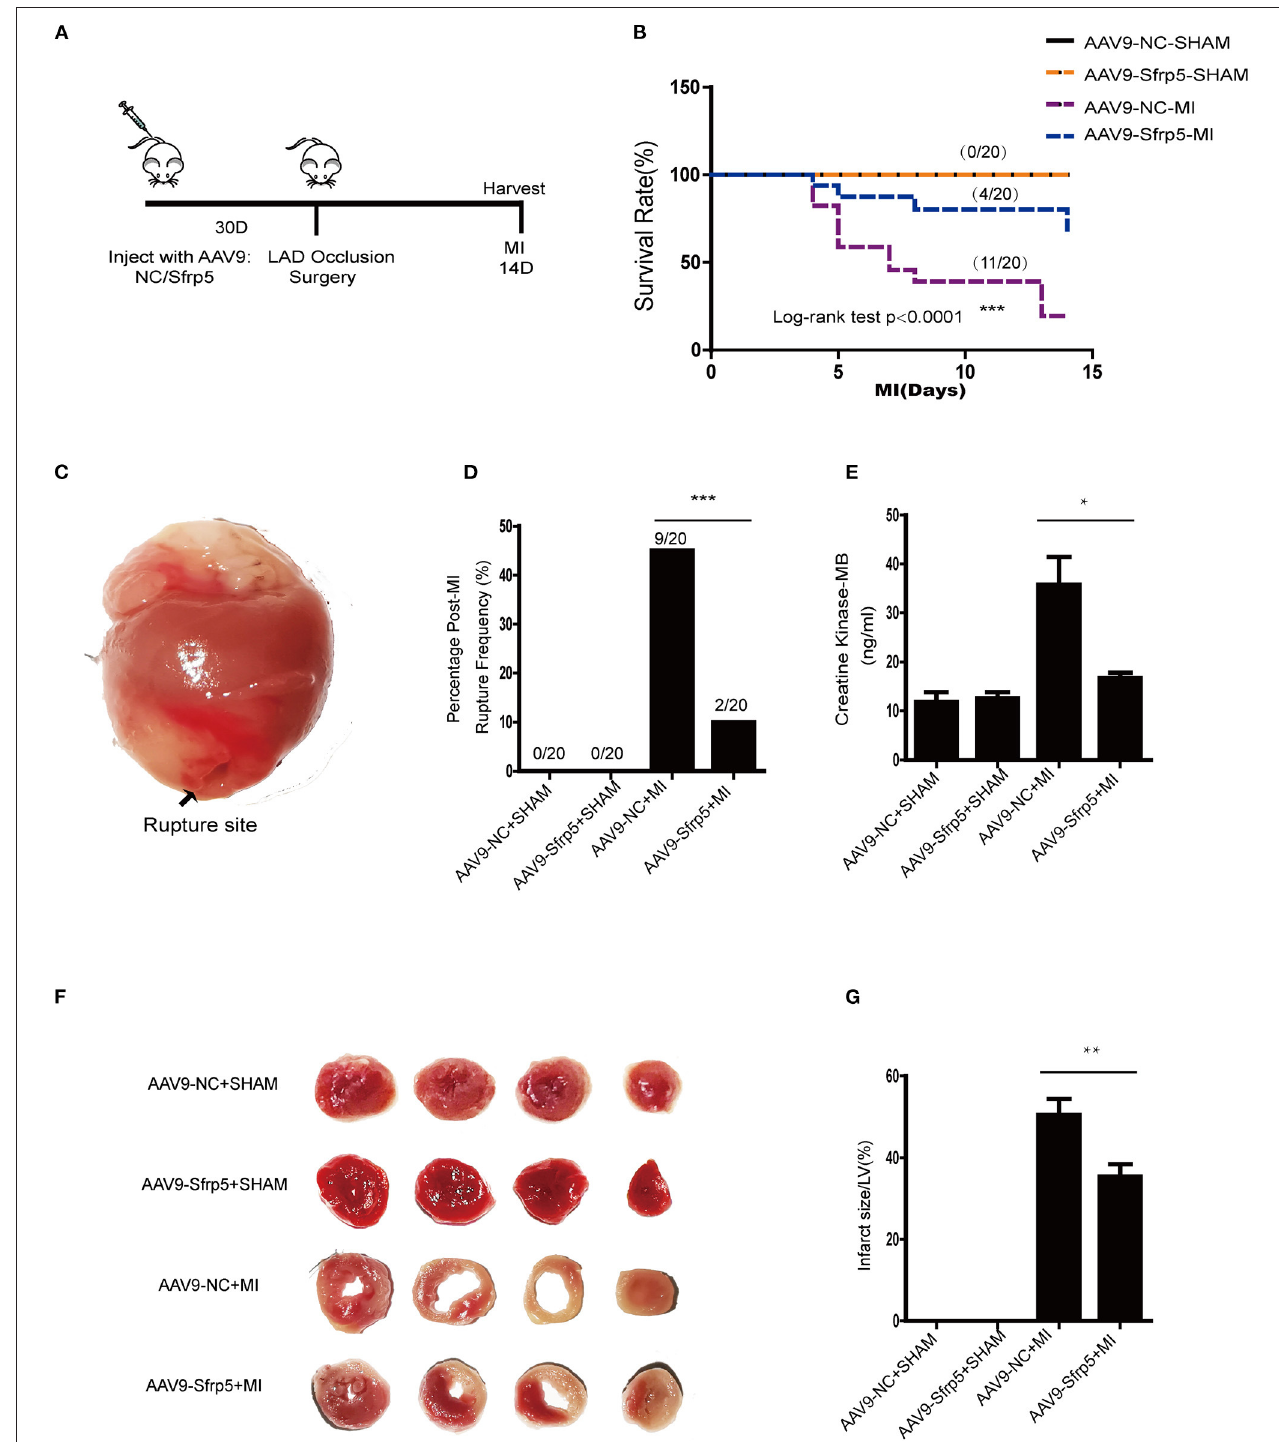
FIGURE 2 | Effects of Sfrp5 on survival and cardiac rupture rate in mice at 2 weeks after MI. (A) Overview of the method for AAV9 injection and the mouse models for MI. (B) Survival rate at 14 days after MI ( n = 20 per group). (C) Representative image of rupture site. (D) Cardiac rupture rate at 2 weeks post infarction ( n = 20 per group). (E) The level of CK-MB at 24h post infarction (values are presented as mean ± SD, n = 6 per group). (F) Representative images of heart sections isolated at 24h post infarction and stained with TTC. (G) Quantitative analysis of the percentage of infarct size (values are presented as mean ± SD, n = 6 per group). * p < 0.05 AAV9-NC-MI mice 1 day after MI vs. AAV9-Sfrp5-MI mice at 1 day after MI. ** p < 0.01 AAV9-NC-MI mice 1 day after MI vs. AAV9-Sfrp5-MI mice at 1 day after MI. *** p < 0.001 AAV9-NC-MI mice 14 day after MI vs. AAV9-Sfrp5-MI mice at 14 day after MI.